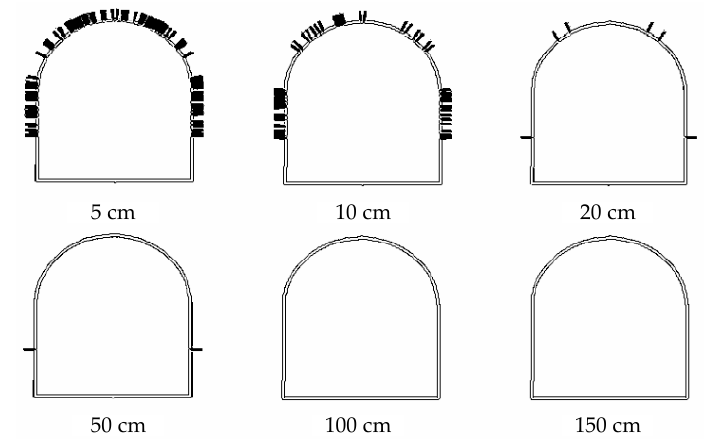
ff erent shotcrete thickness.